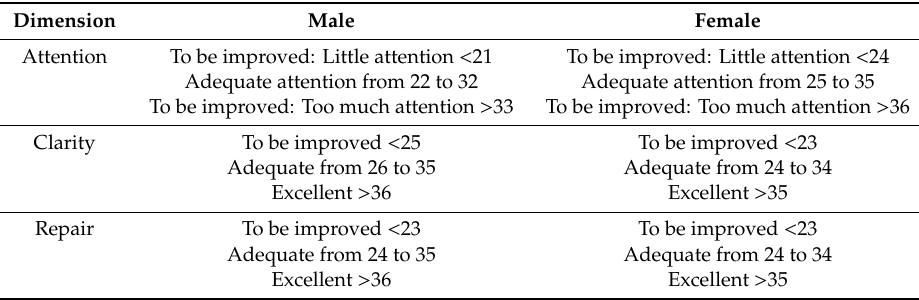
Table 1. Interpretation of the Trait Meta-Mood Scale (TMMS)-24